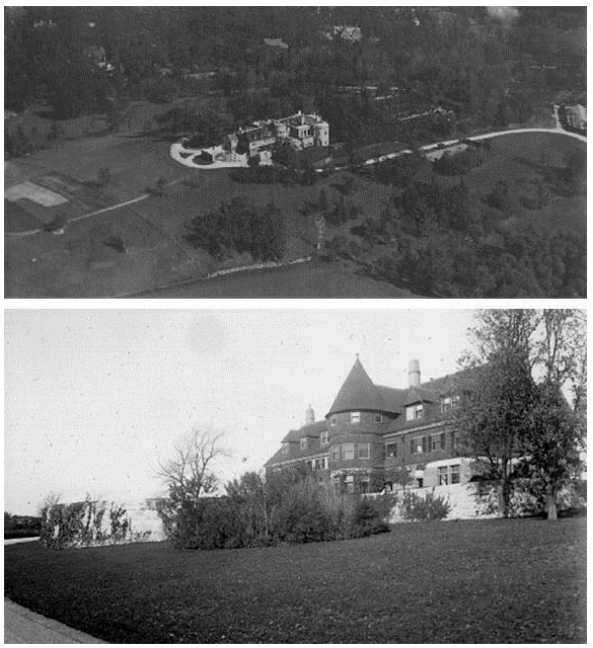
Figure 2. Larz Anderson Auto Museum on opening day in 1953.